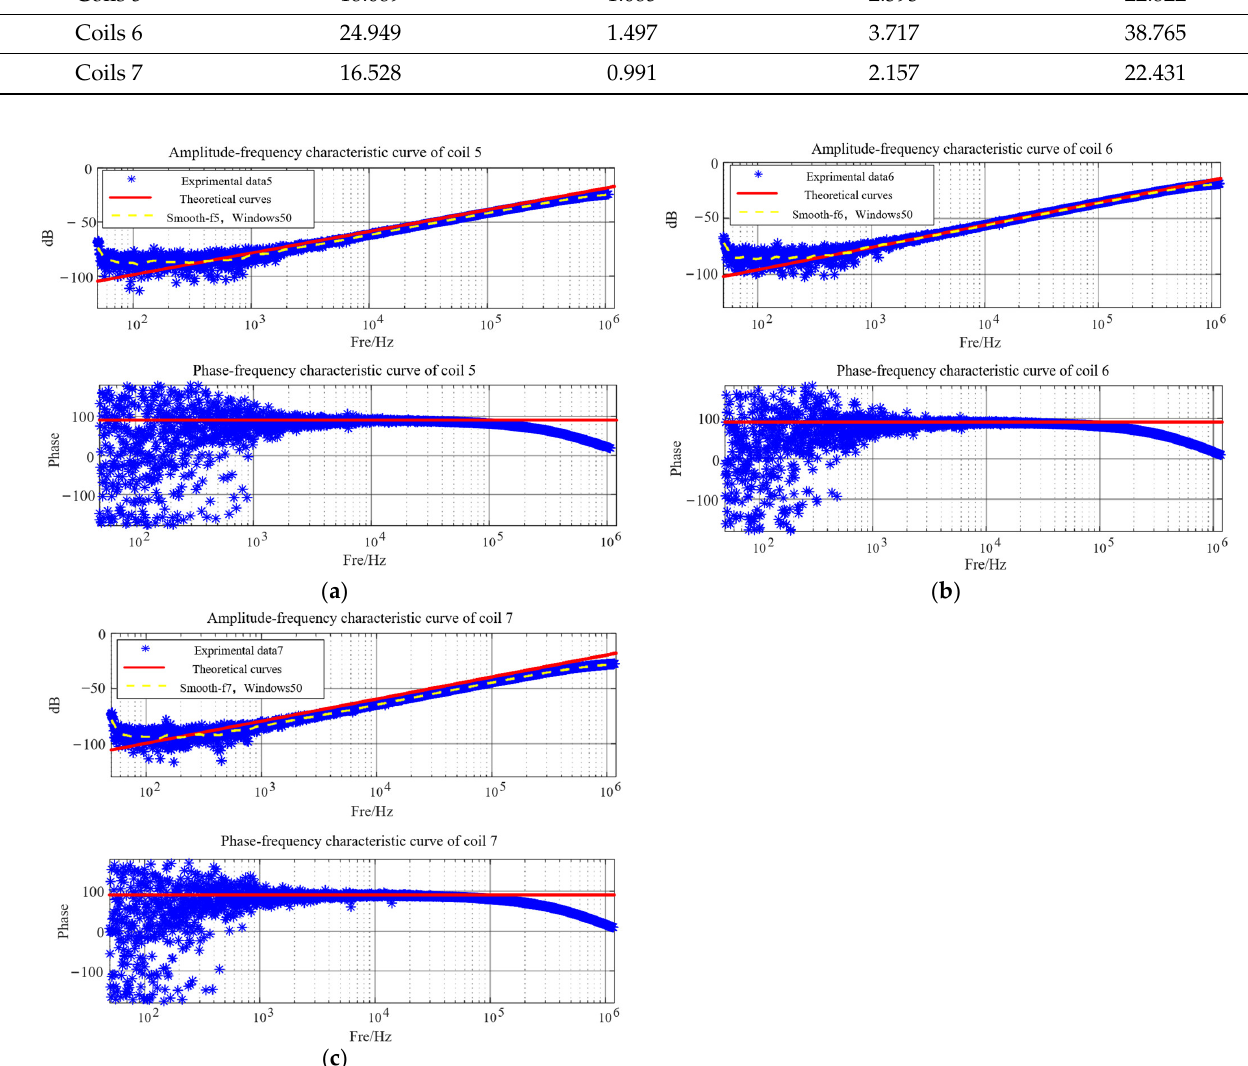
Figure 14. Bode diagram of coil 5–7 ( a ) Coil 5. ( b ) Coil 6. ( c ) Coil 7. The measured curves of the amplitude-frequency characteristic curve and phase-fre- quency characteristic curve are consistent with the theoretical curve in the frequency range of 1 kHz to 100 kHz. The phase frequency characteristic curve decreases slightly after 100 kHz, which is caused by the coupling capacitance, and the higher the frequency, the more obvious this phenomenon is. Moreover, since the mutual inductance coefficient is at the nH level, even a large measurement error is not obvious on the Bode plot. Therefore, it is necessary to fit the experimental data of these three coils in a curve and calculate the experimental value of the mutual inductance coefficient to obtain the measurement error. The calculated values of mutual inductance coefficient obtained by curve fitting are shown in Table 6. If coil 5 is used as the experimental control group, coil 6 is the ex- perimental group with an 11.6 mm increase in outer diameter and coil 7 is the experi- mental group with a 2 mm increase in inner diameter. As can be seen from Table 6, the theoretical mutual inductance value of coil 6 is larger than that of coils 5 and 7, and its experimentally measured error value is relatively smaller. Therefore, when the differen- tial winding coil is used for the measurement of capacitor ripple current, it is very im- portant to maximize the use of the capacitor surface size and design reasonable structural parameters to maximize the mutual inductance coefficient.